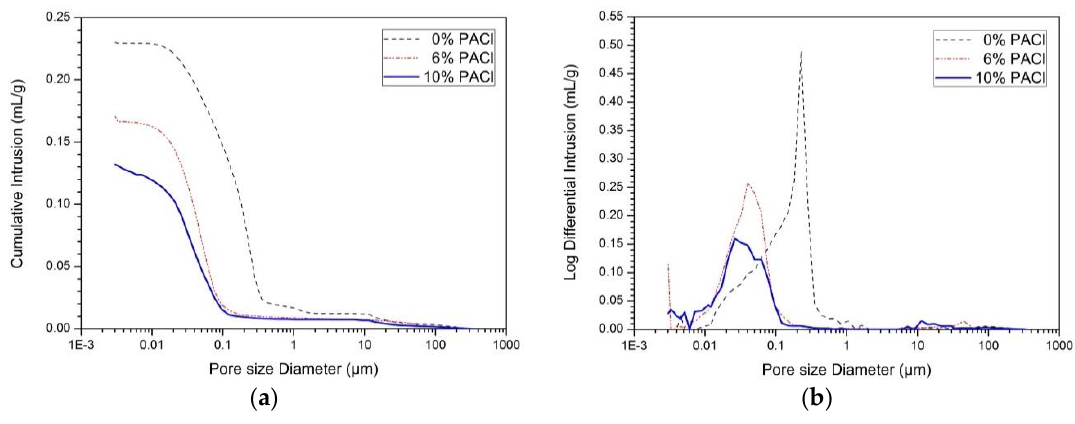
Figure 2. Results of mercury intrusion porosimetry, which gives ( a ) the cumulative intrusion and ( b ) the log differential intrusion as a function of pore diameter.